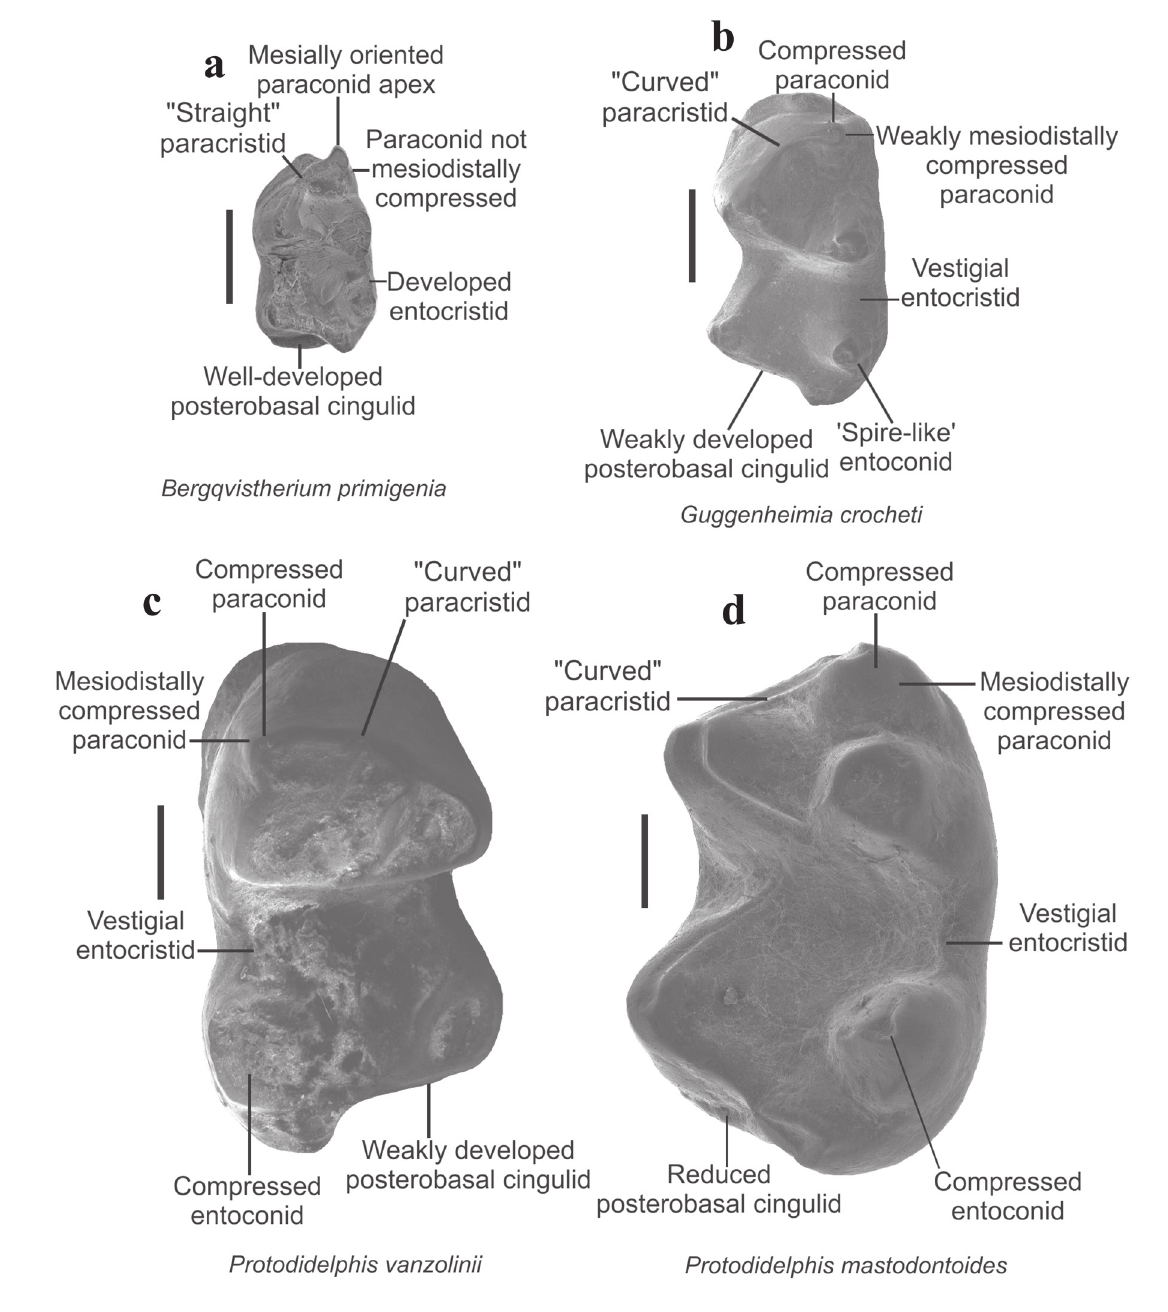
Figure 3 - Comparative morphology of the lower molars of the Brazilian protodidelphids. Differential morphology between Bergqvistherium , Guggenheimia and Protodidelphis : a , Bergqvistherium primigenia : MCt 4387-M, a left m3 (type specimen), in occlusal view; b , Guggenheimia crocheti : DGM 314-M, an incomplete left dentary with m2-4 and alveoli of i1-m1 (type specimen), showing the m3 in occlusal view; c , Protodidelphis vanzolinii : DGM 250-M, nearly complete right dentary, showing the m3 in occlusal view; d , Protodidelphis mastodontoidea : MCT 2819-M, left m2 in occlusal view. The proportional size difference between these taxa is preserved. Scale bars: